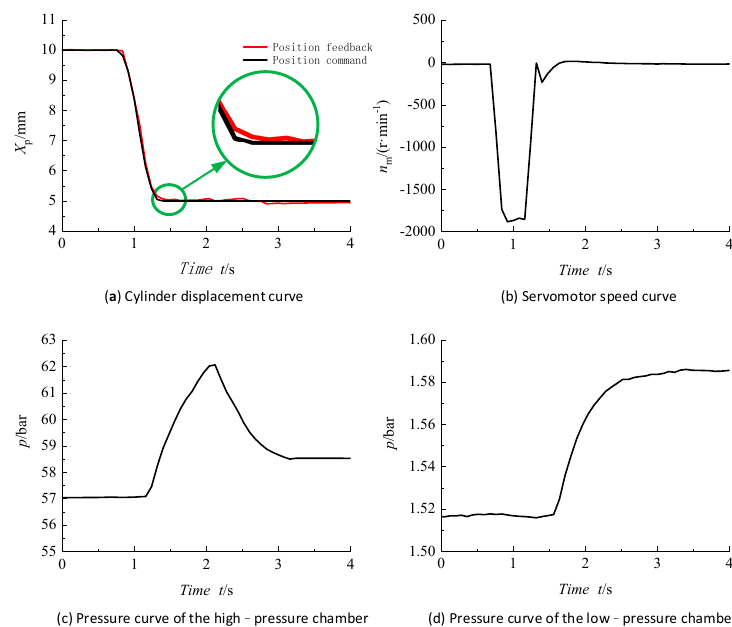
Figure 9. The response curve of valve opening test.